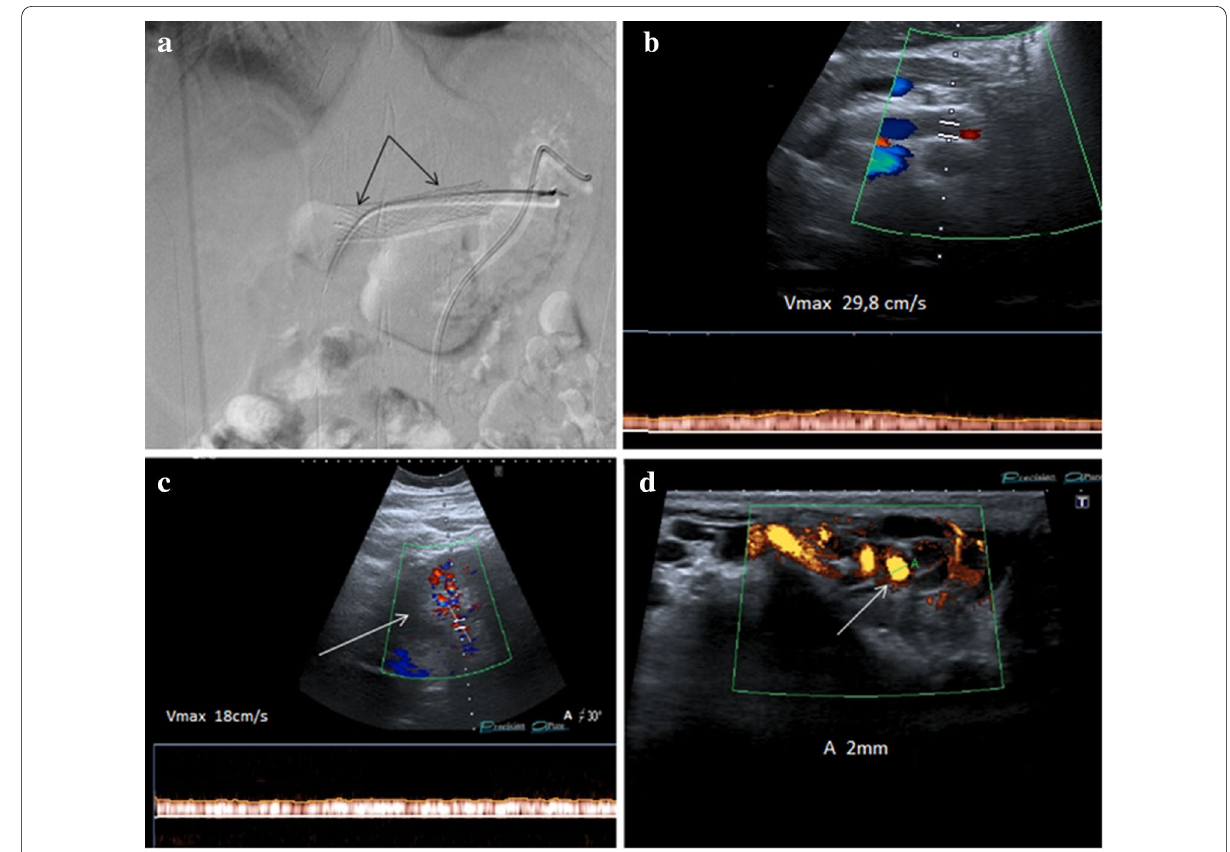
the patency of the vascular stent showing a flow with a peak velocity of about 29.8 cm/s. c After stenting, Color Doppler US show a increased flow of the left renal vein (18 cm/s). d Power Doppler US shows a regular caliber of the pampiniform plexus vein (diameters of 2